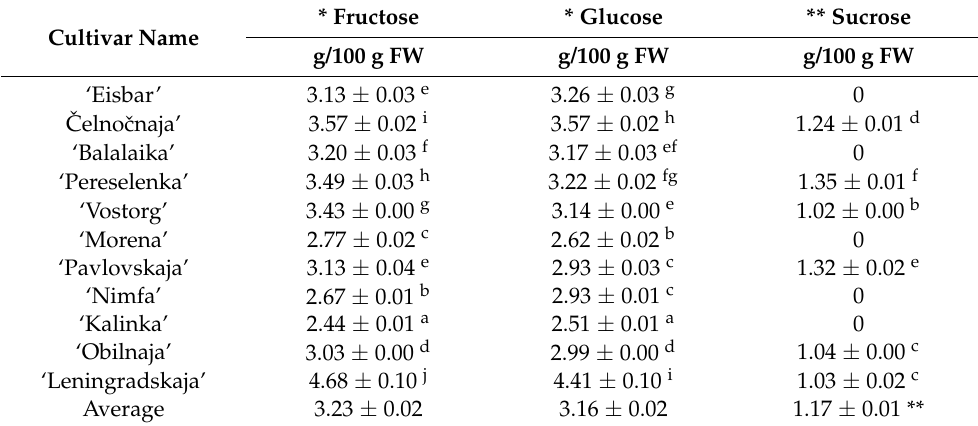
Table 4. Contents of saccharides (means ± SD) in berries of Lonicera caerulea